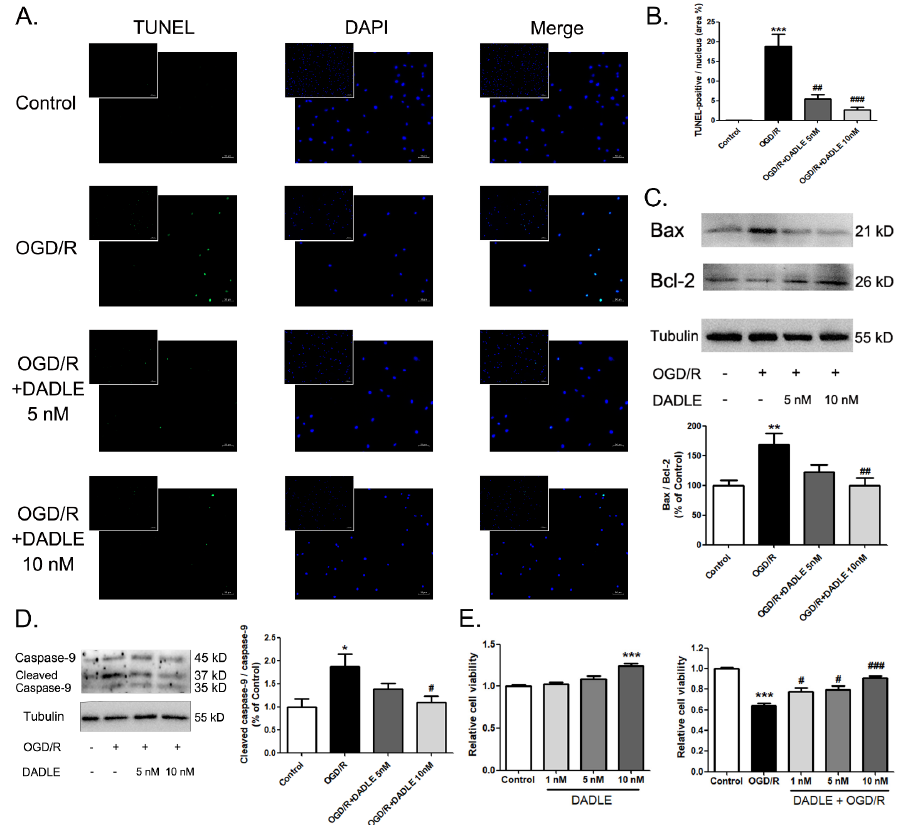
Figure 4. DADLE reduce apoptosis in the primarily cultured brain microvascular endothelial cells (BMECs) caused by the oxygen-glucose-deprivation/reoxygenation (OGD/R) via reducing the cleaved caspase-9 and the ratio of the protein level of Bax and Bcl-2 and then increase their via- bility in a dose-dependent manner. ( A ) TUNEL staining detection of OGD/R-treated BMECs with or without DADLE (5 nM or 10 nM). TUNEL-positive cells were stained green. Nuclei were stained with DAPI and showed as blue. ( B ) Statistical analysis of the TUNEL-positive nuclei (as the area percentage of total nuclei), n = 3. ( C ) Western blotting analysis of the expression of Bax and Bcl-2. Statistical analysis showed the ratio of Bax and Bcl-2, n = 8. ( D ) Western blotting analysis of the ex- pression of caspase-9 and cleaved-caspase-9. Statistical analysis showed the ratio of cleaved-caspase-9 and caspase-9, n = 5. ( E ) CCK8 assay evaluated the relative cell viability after 12 h OGD following 6 h reoxygenation with or without DADLE, n = 4. Data were normalized compared to the control group. Bars represent the mean ± S.E.M.* p < 0.05, ** p < 0.01, *** p < 0.001 versus the control group. # p < 0.05, ## p < 0.01, ### p < 0.001 versus the OGD/R